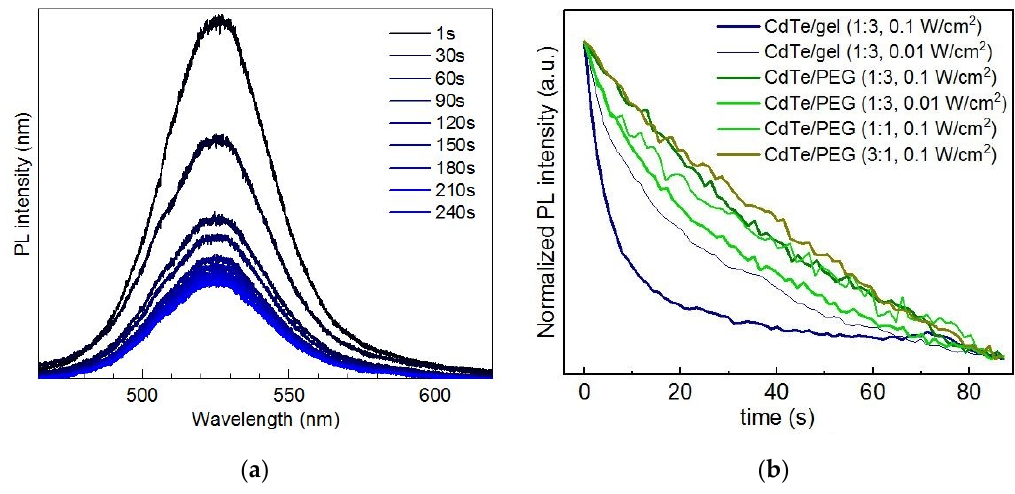
Figure 10. ( a ) Evolution of the representative room-temperature PL spectra ( λ exc = 325 nm, 0.1 W/cm 2 ) of CdTe/CdS NCs embedded in gelatin. ( b ) Time-dependent behavior of PL intensity ( λ exc = 515 nm, power density indicated in the legend) CdTe/CdS NCs embedded in gelatin and PEG at different volumetric ratios of NC:polymer.